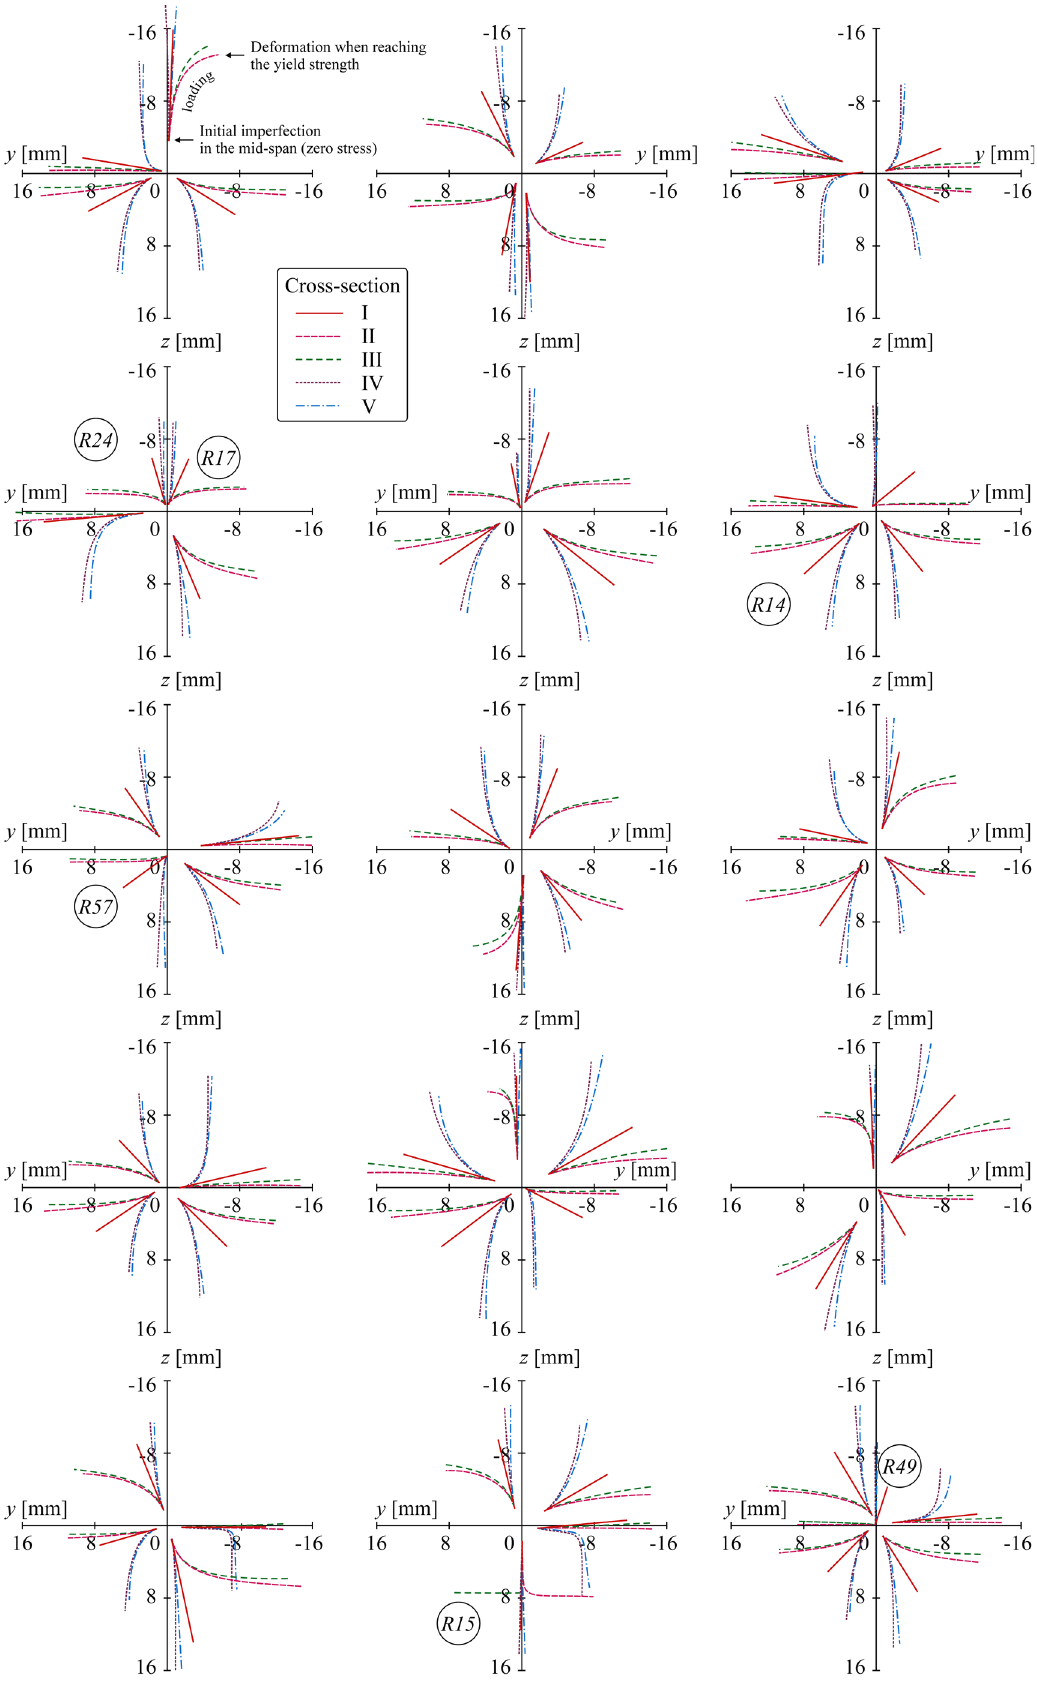
Fig. 8. Deflection curves of columns at the node in x = L